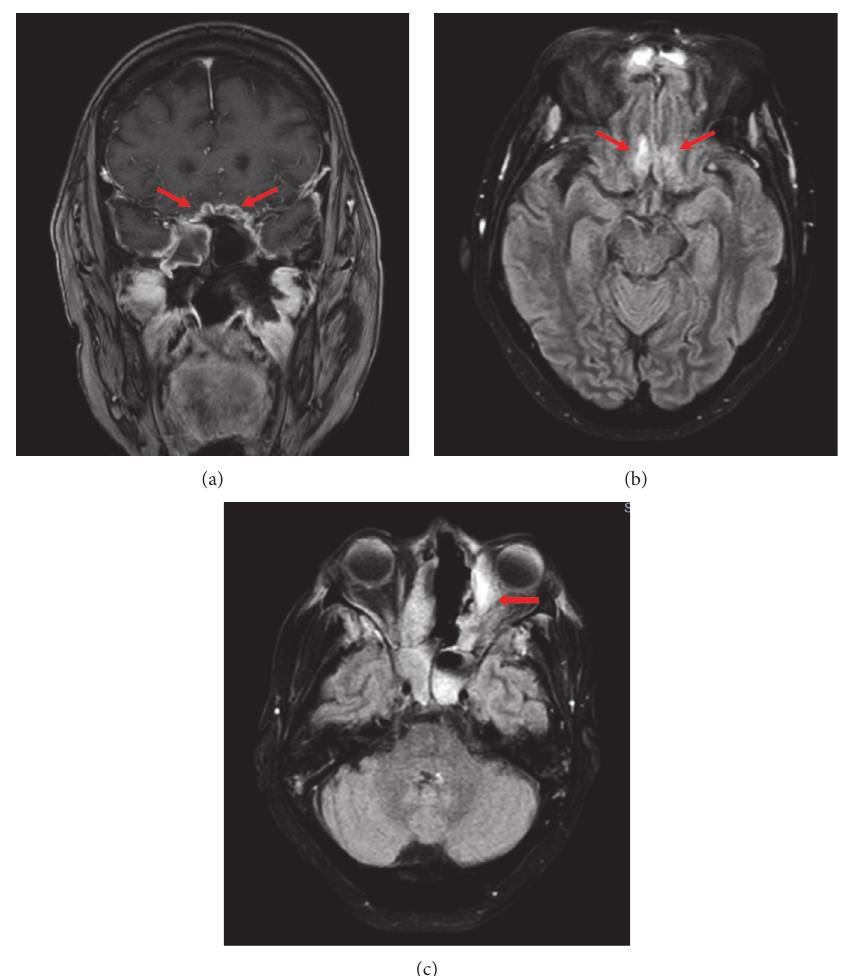
Figure 3: (a) Coronal T1-weighted contrast-enhanced MRI reported frontal anterobasal dural thickening and strong pachymeningeal enhancement (arrows). (b) Fluid attenuated inversion recovery (FLAIR) sequence showed hyperintense signal in cortical anterobasal frontal lobes (arrows). (c) FLAIR sequence revealed an abscess adjacent to the inferior rectus muscle of the left orbit (red